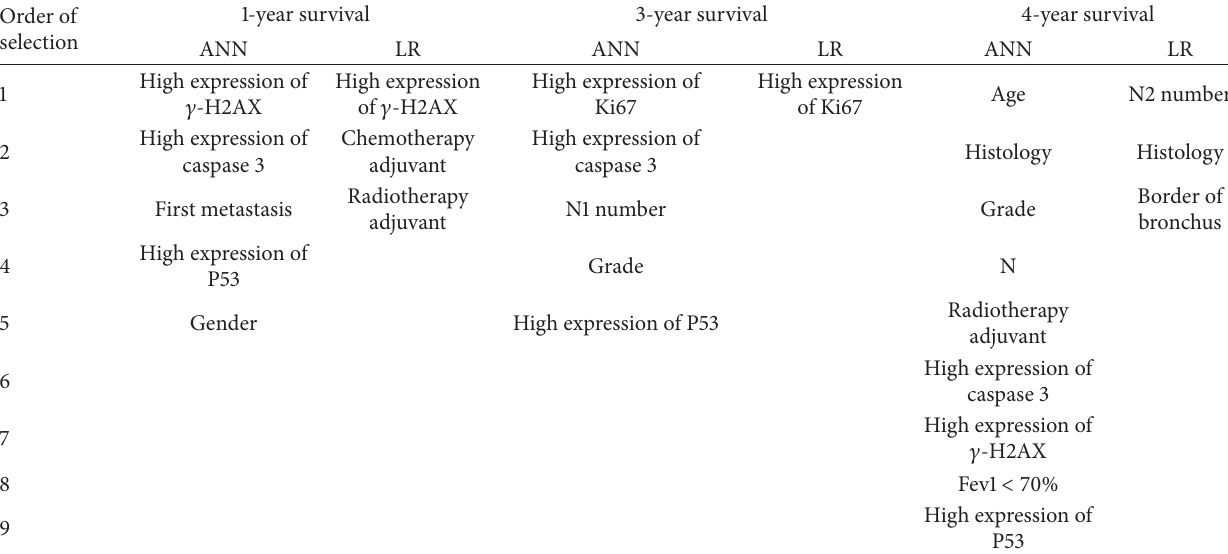
Table 2: Selected input variables by the parameter-increasing